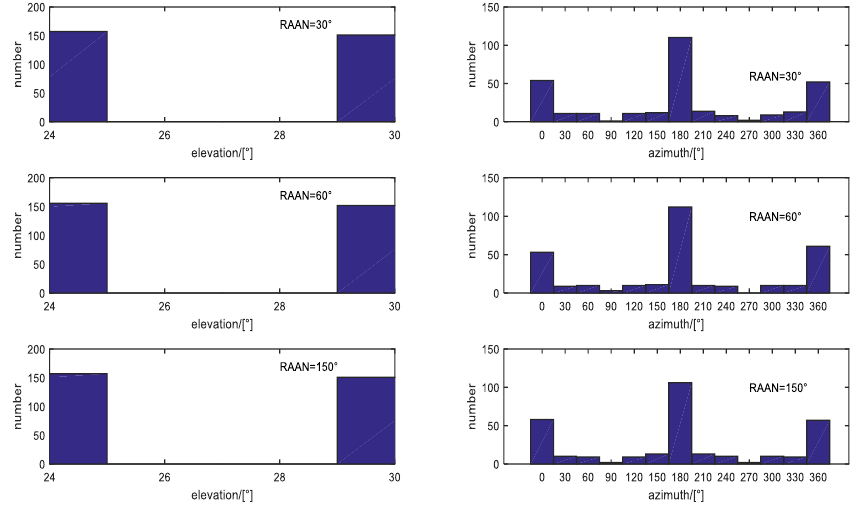
Figure 13. Variations in the elevation angle and azimuth with RAAN .